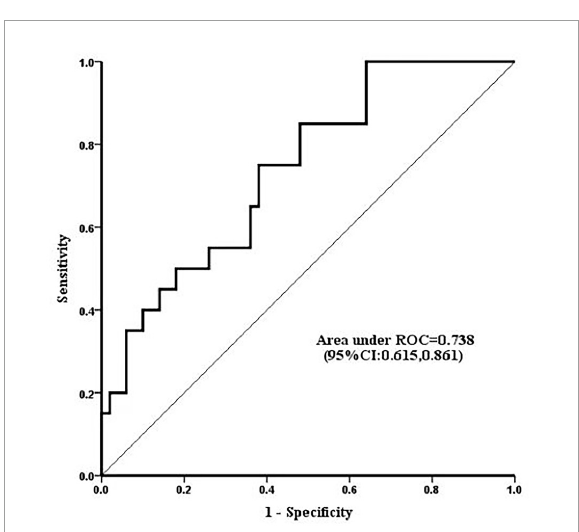
FIGURE3 Receiver operating characteristic curves displaying the ability of serum level of calpains 1 h after cardiopulmonary bypass (CPB) to predict the occurrence of acute lung injury (ALI). The area under the curve (AUC) of serum calpains’ level 1 h after CPB for ALI was 0.738 (95% CI 0.615,